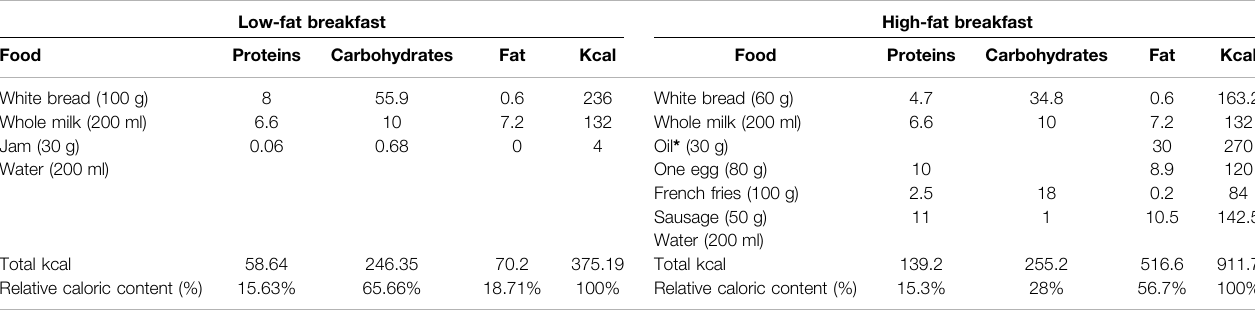
TABLE 1 | Content of the low-fat and high-fat